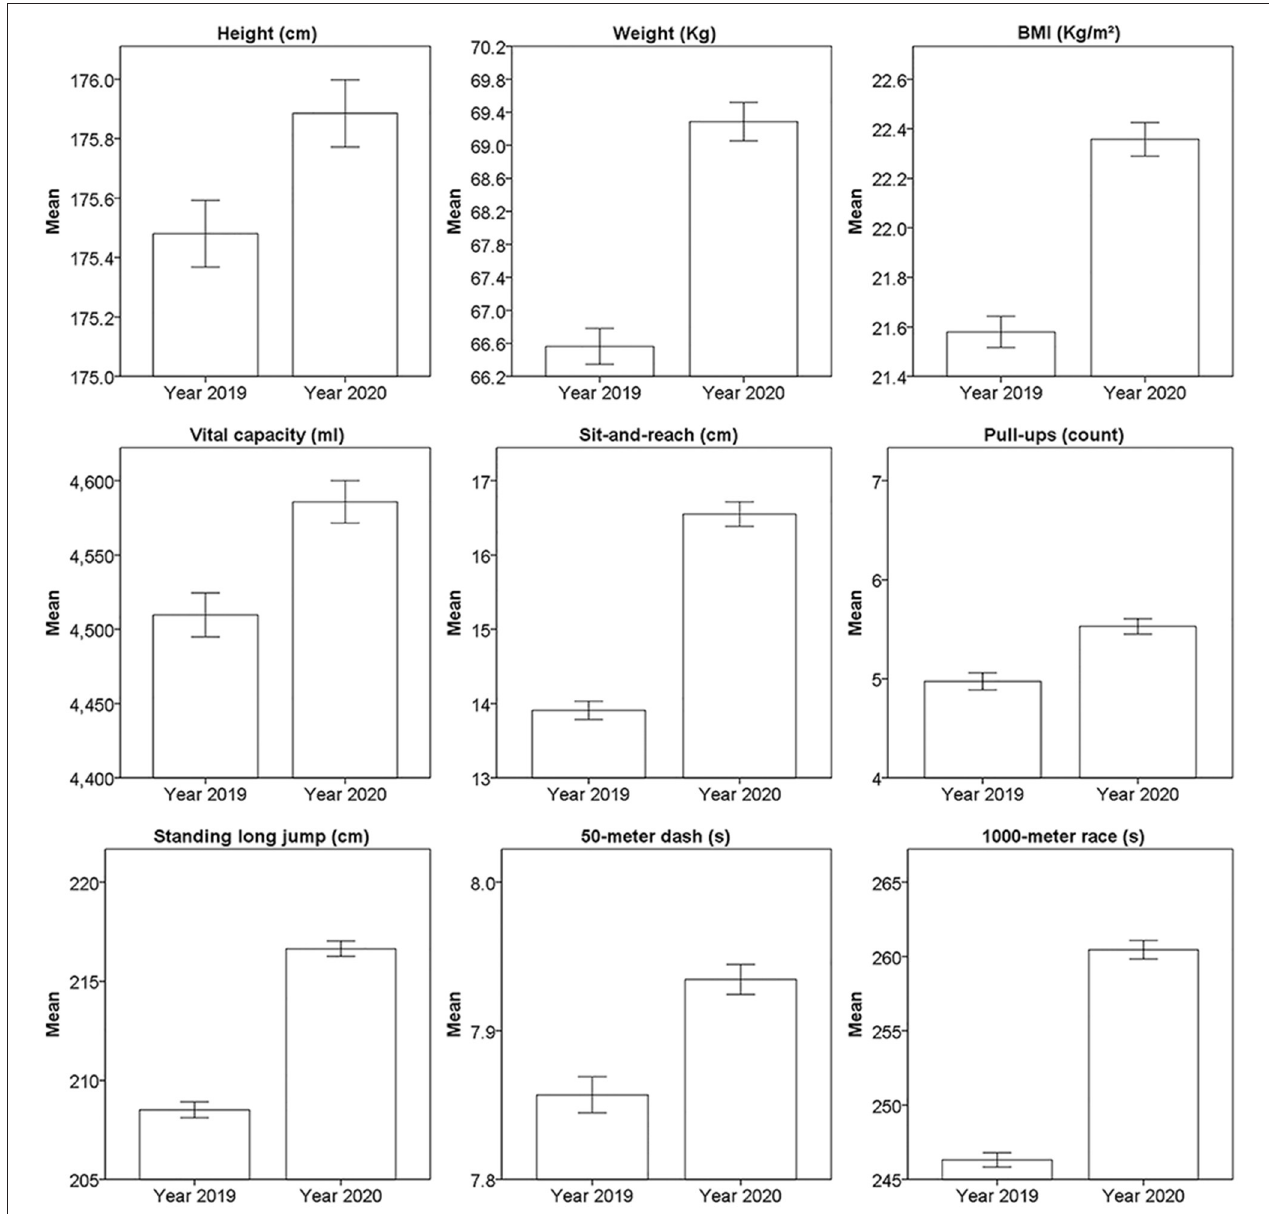
FIGURE 4 | The mean and 95% confidence interval of physical fitness tests from 11,219 male